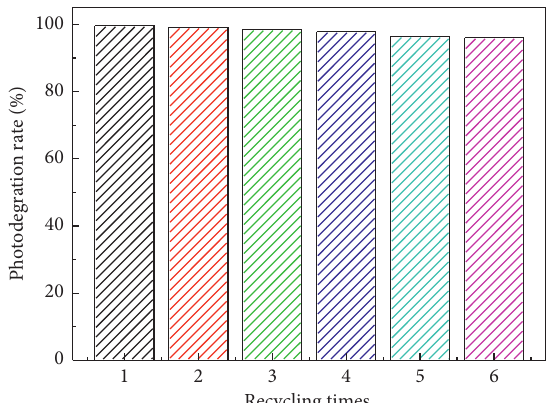
Figure 12: Cycling stability of the HBSMs for degradation of the MO.